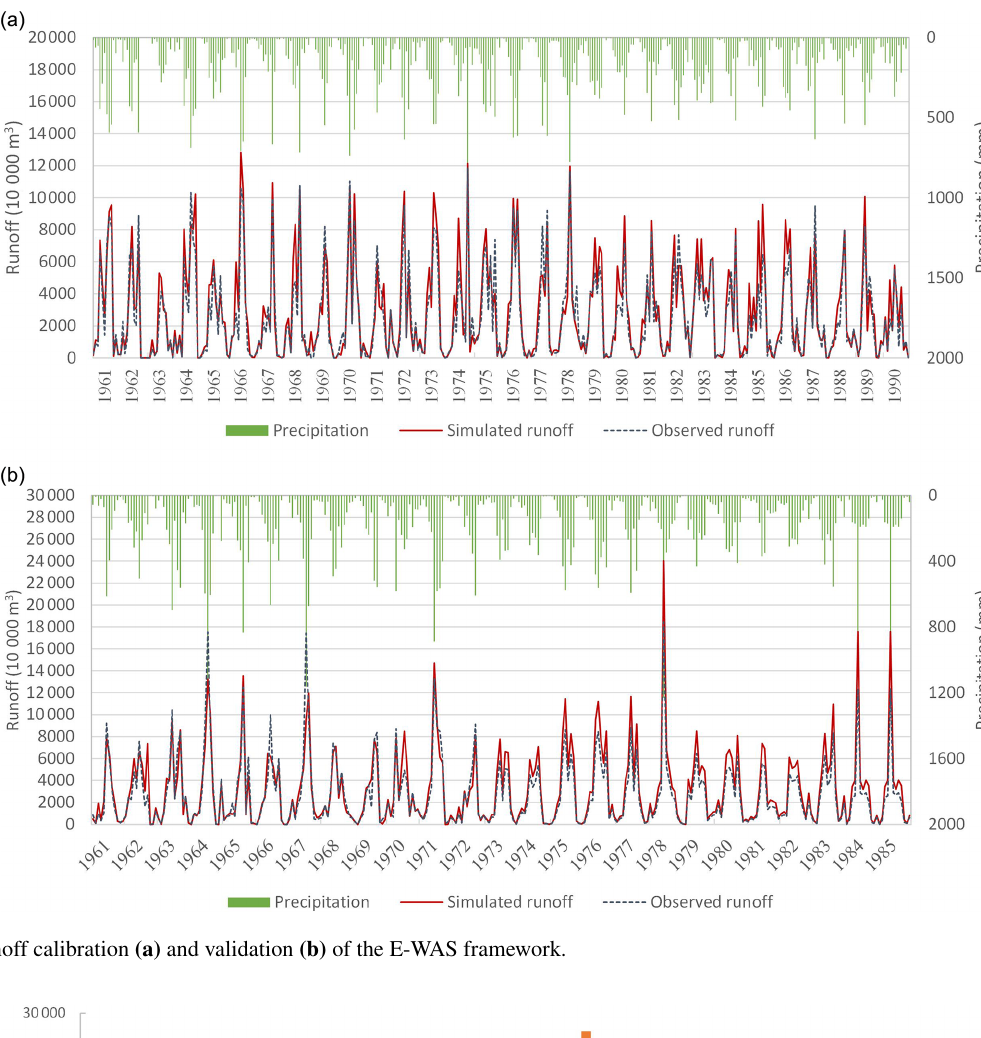
Figure 5. Runoff calibration (a) and validation (b) of the E-WAS framework.